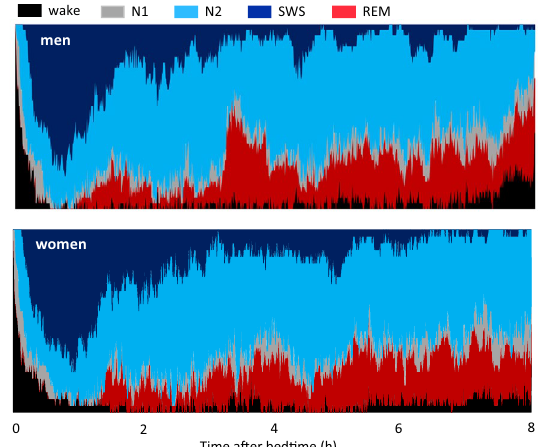
Figure 5. Cumulative display of sleep architecture during simultaneous assessment of energy metabolism. The percentage of subjects in each sleep stage is shown for men (upper panel) and women (lower panel). The total number of subjects was 38 men and 27 women (11 in follicular phase, 11 in luteal phase, and 5 cases without record). Subjects slept for 8 h in a metabolic chamber for indirect calorimetry 8,23–25 . In this dataset, the nadir of the RQ was 3.00 ± 0.26 and 2.04 ± 0.39 h after bedtime for the men and women, respectively (P <